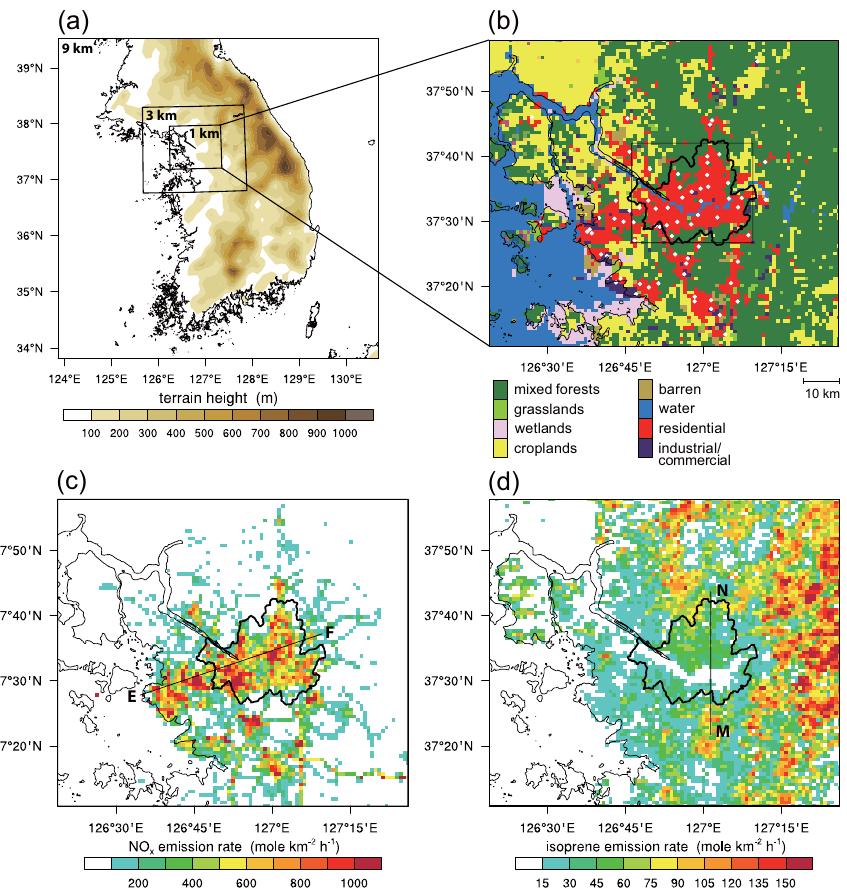
Fig. 1. (a) Domain configuration of the CMAQ model simulation with terrain height (shaded). (b) Land use/land cover (LULC) in the innermost domain. Only dominant LULCs are indicated in the legend. The white circles indicate air quality monitoring sites whose data are used for the validation. The rectangle indicates the urban analysis area, and the thick line indicates the administrative boundary of Seoul. (c) NO x and (d) isoprene emission rates at 15:00 LT 24 June 2010 in the innermost